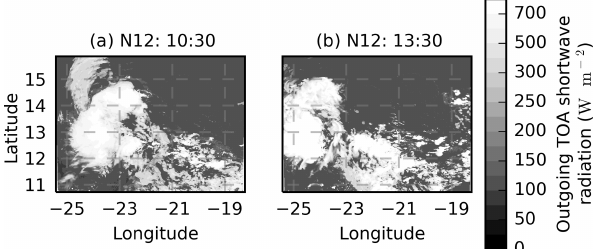
Figure A1. The cloud field. Simulated top-of-atmosphere outgoing shortwave radiation for the N12 simulation at 10:30 (a) and 13:30 (b) .